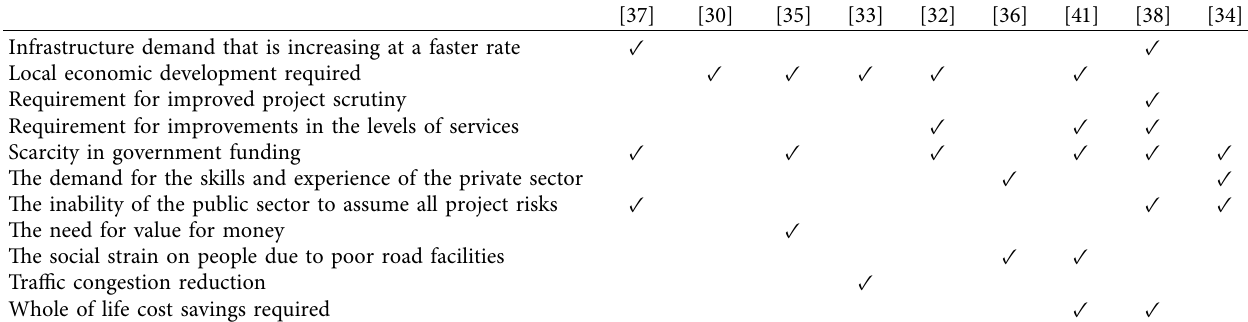
Table 1: Summary of reasons for PPP